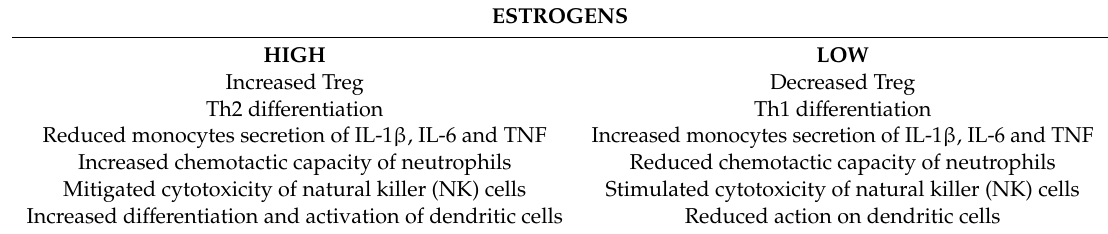
Table 1. Action of estrogens on several immune parameters depending on their